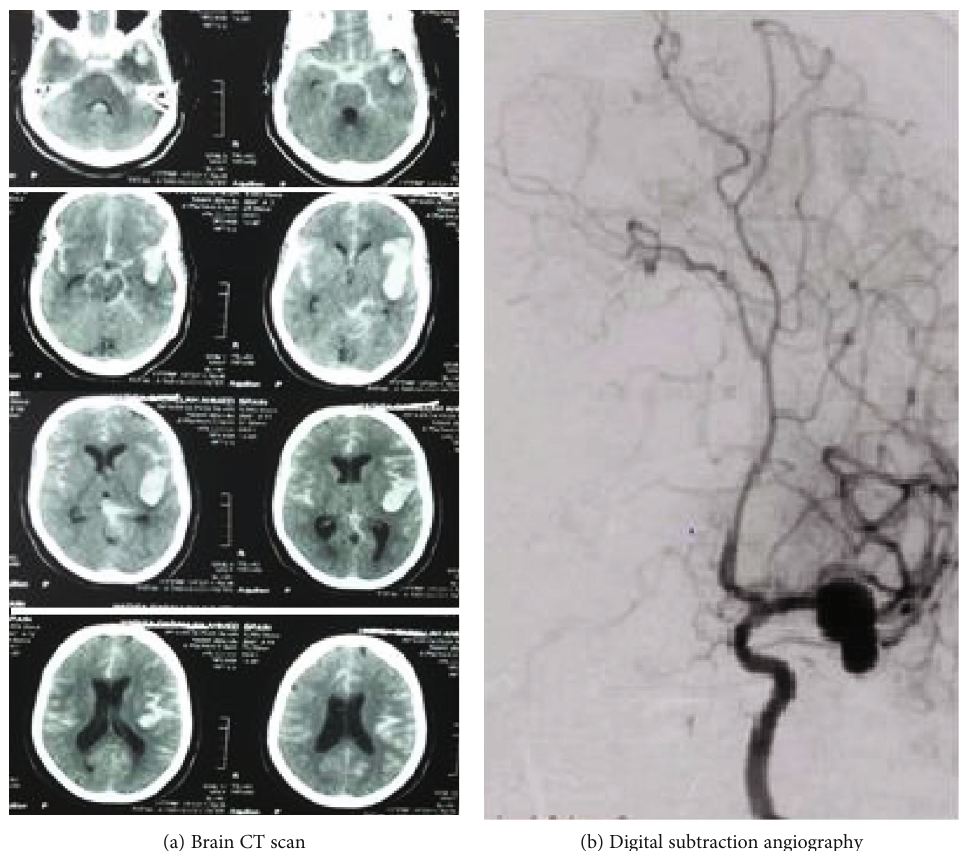
Figure 2: Diagnosis of aSAH by brain CT scan and digital subtraction angiography. (a) Brain CT scan was done revealing subarachnoid hemorrhage. Hunt and Hess scale was III. (b) Digital subtraction angiography was done showing the left MCA